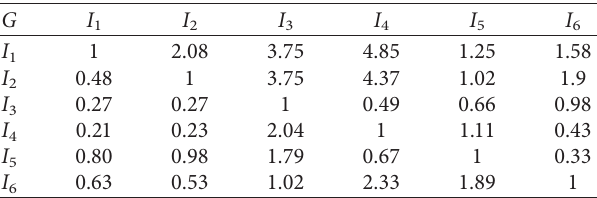
Table 11: Weightage of the indicators by AHP on topic attributes. 1 .